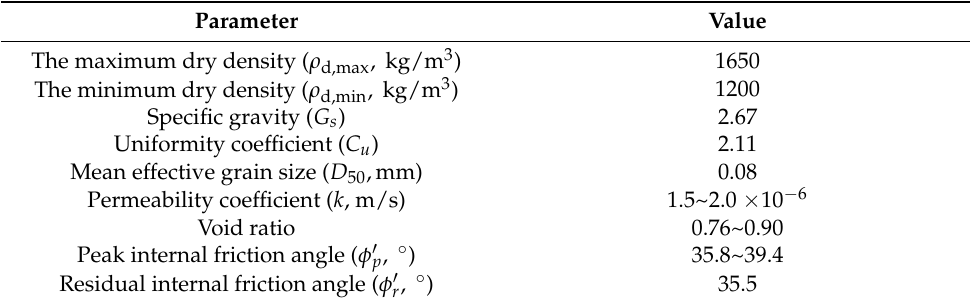
Table 2. Fundamental parameters of GS soil sample.